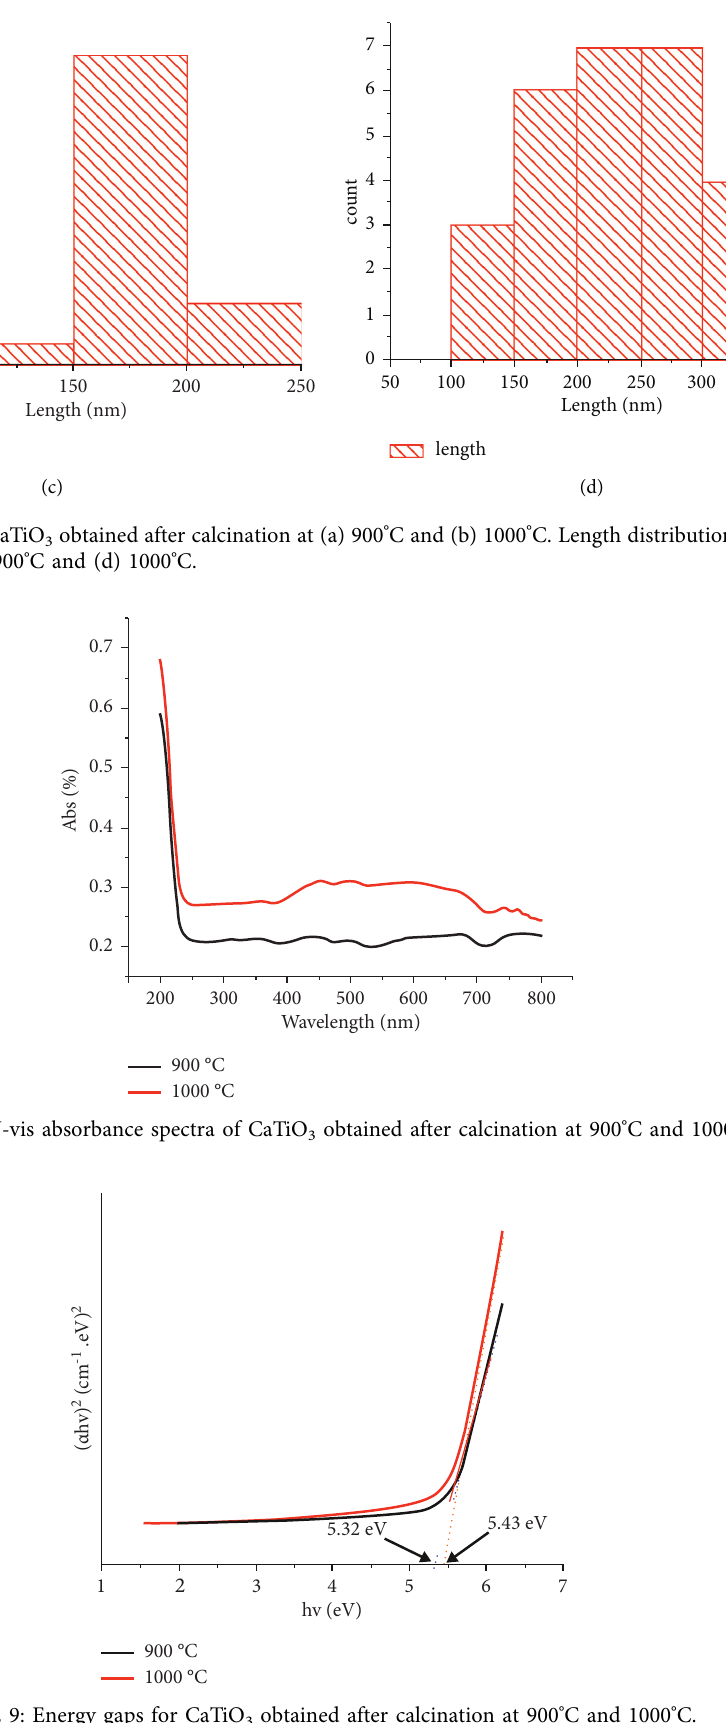
3 obtained after calcination at 900